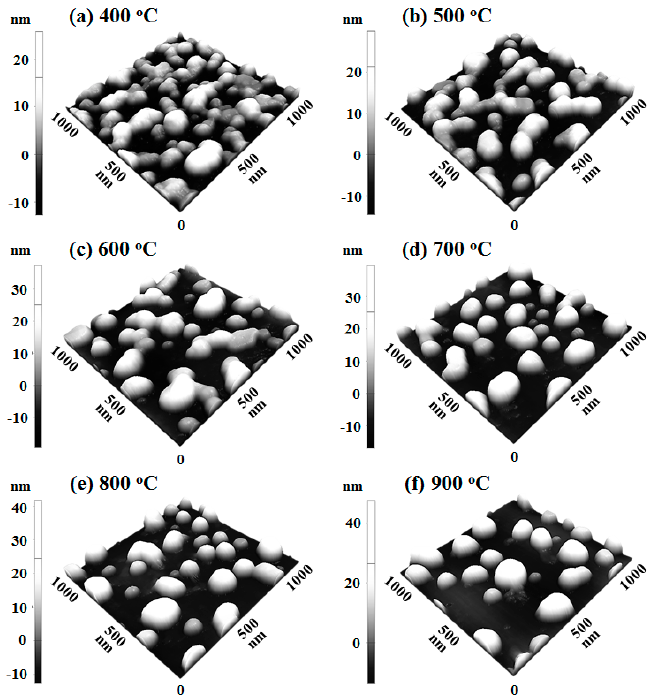
Figure A7. Tri-layer deposition order on the evolution of AuAgPd NPs at increased temperature between 400 and 900 °C. The tri-layers consist of 2 nm thick Pd, Au, and Ag layers in sequence (Pd:Au:Ag = 1:1:1). ( a – f ) AFM side-views of 1 × 1 µm 2 .